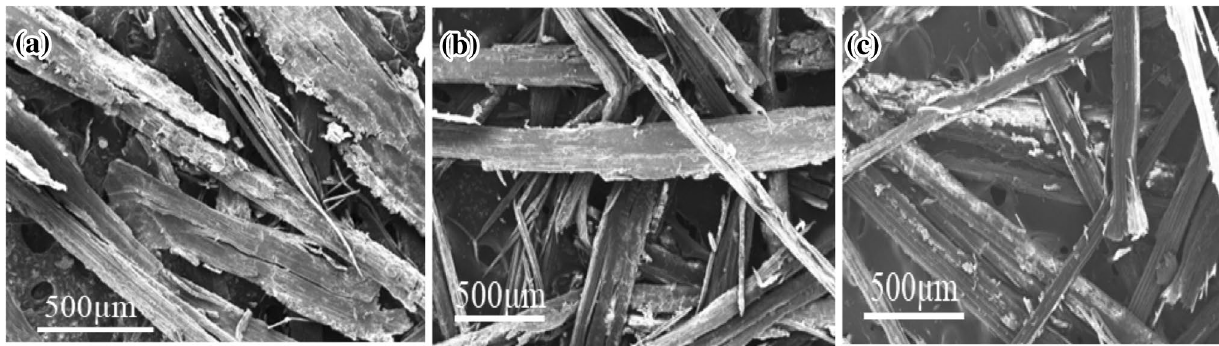
Fig. 6 SEM image of a 6% b 12% c 18% alkali treated Y.alpina bamboo fiber micromorphology